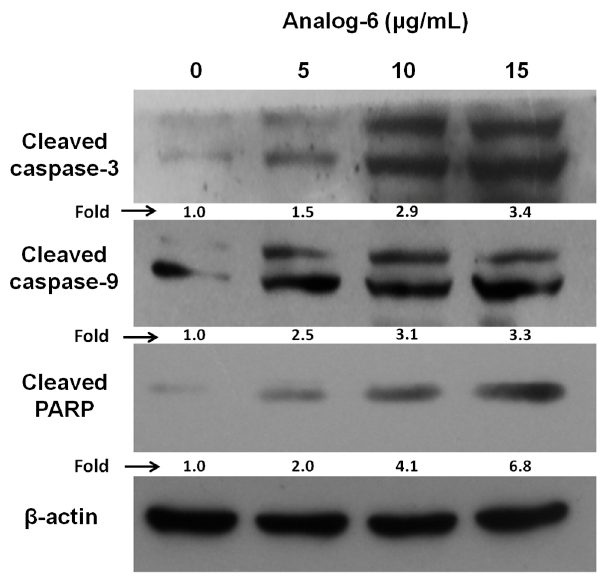
Figure 6. Western blot results display the expression of the cleaved caspase-3, caspase-9 and cleaved PARP of HepG 2 cells after being treated with 0, 5, 10 and 15 µg/mL Analog-6 for 48 h.